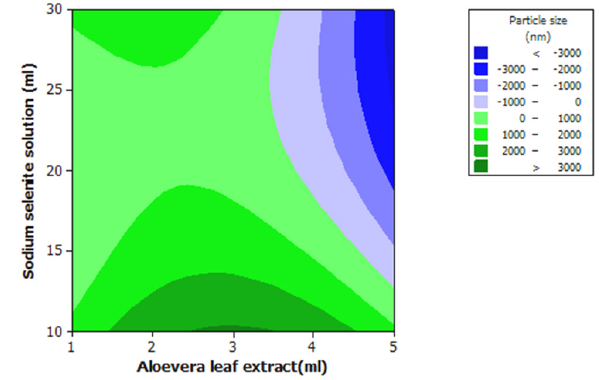
Figure 3: Contour plot of colour intensity of the solution containing Se NPs as function of amount of Na extract.